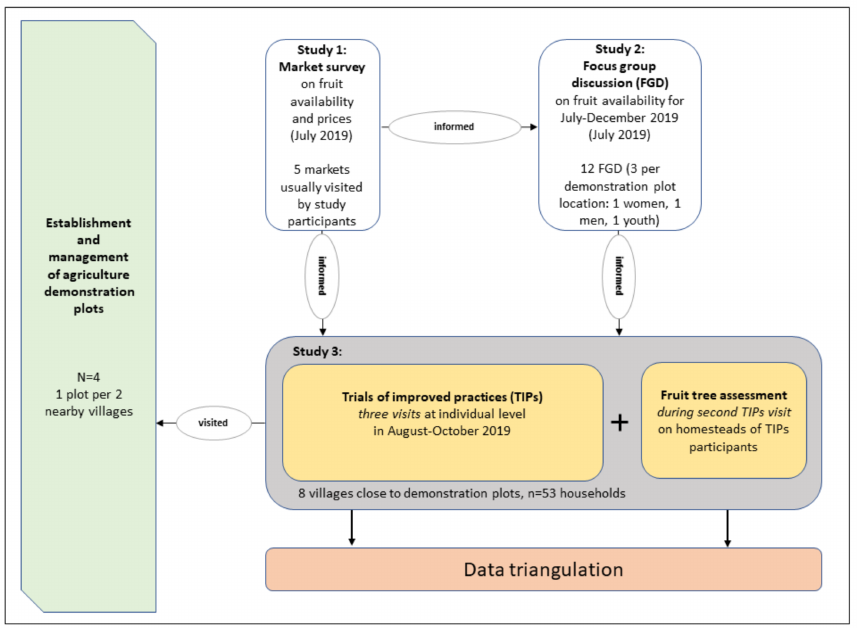
Figure 1. Multiphase mixed method study